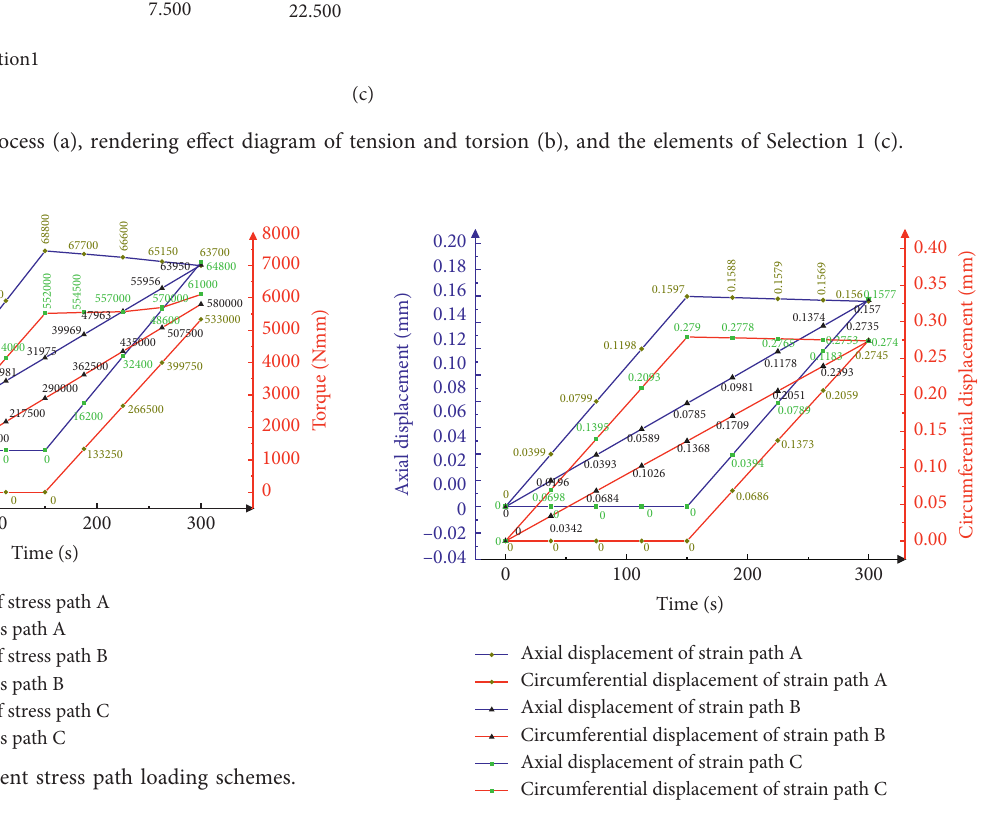
Figure 12: Three different strain path loading